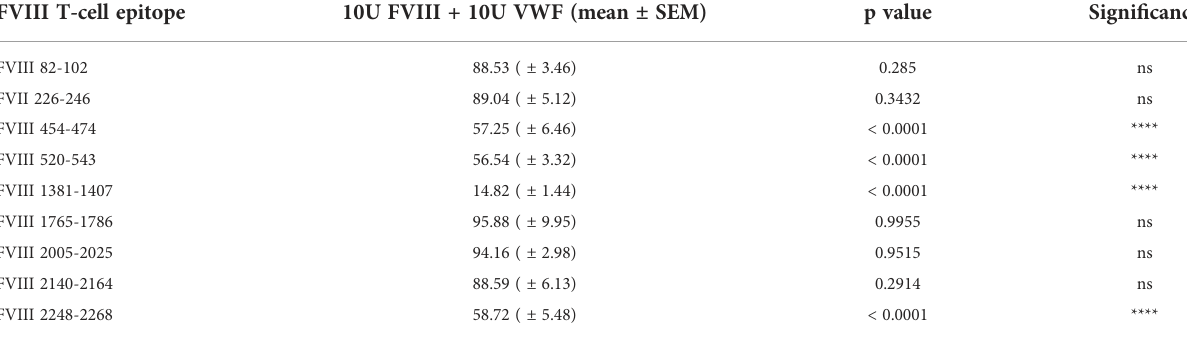
TABLE 2 In fl uence of VWF present during preincubation of APCs with FVIII on the peptide speci fi city of subsequently activated FVIII-speci fi c CD4 + T cell hybridoma clones. FVIII T-cell